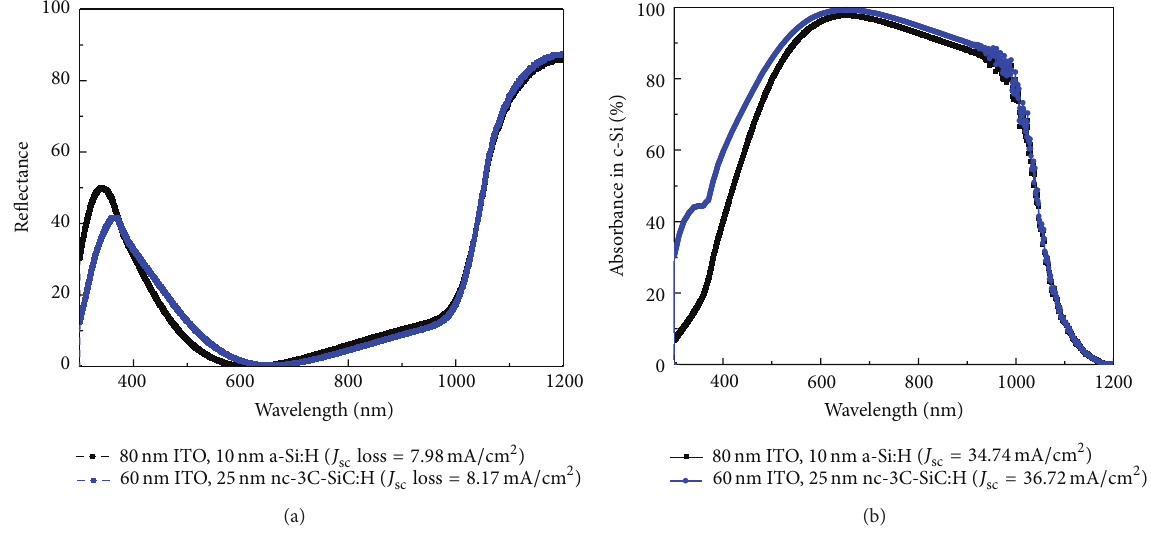
Figure 3: (a) The reflectance spectra for SHJ solar cells with nc-3C-SiC:H emitter and a-Si:H emitter with a single AR coating (b). The corresponding absorbance. The absorbance spectra are the absorbance in c-Si layer in the solar